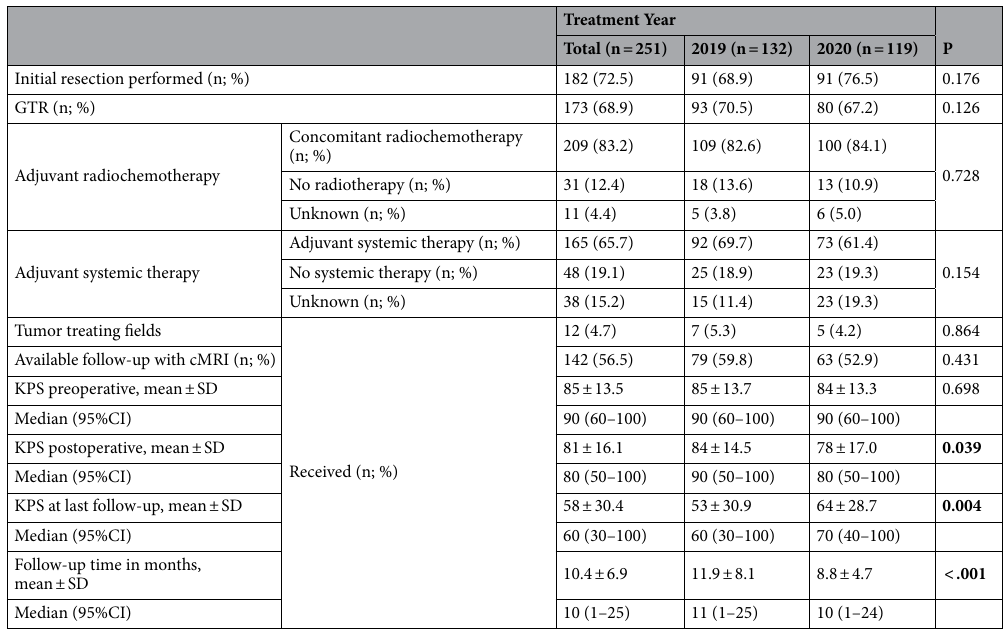
Table 5. Procedures performed in comparison between the 2019 and 2020 cohorts. GTR—gross total resection; cMRI—cranial magnetic resonance imaging. SD—standard deviation; 95%CI—95% confidence interval. Significant values are in [bold].